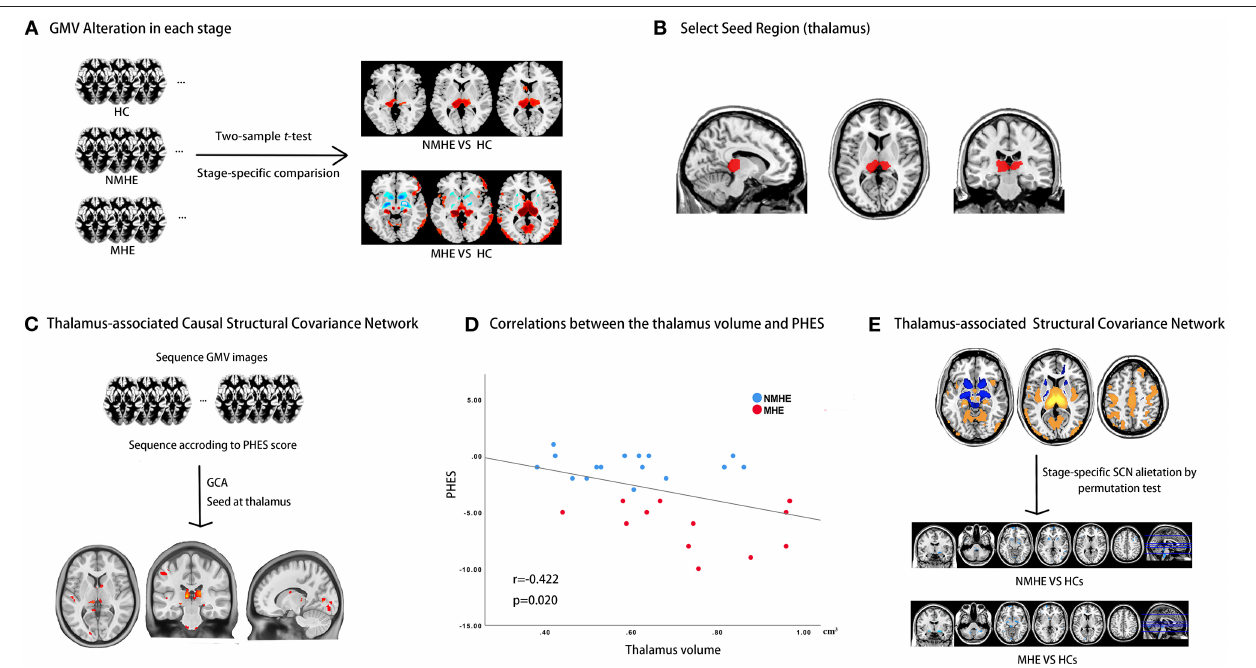
FIGURE 1 | Study design schematic. (A) HBV-RC patients were categorized into NMHE and MHE according to PHES; overall and stage-specific gray matter (GM) alterations were calculated by comparing overall cirrhotic patients, NMHE patients, and MHE patients with HCs separately. (B) The bilateral thalamus was extracted as the seed region based on prior analysis for subsequent causal network of structural covariance (CaSCN) analysis and structural covariance network (SCN) analysis. (C) The thalamus-associated CaSCN was constructed, and sequenced alterations related to the thalamus were derived during the progression of MHE. (D) The correlation between the thalamus volume and PHES in HBV-RC patients was evaluated by Spearman’s correlation analysis. (E) The thalamus-associated SCN was constructed, and stage-specific SCN alterations were calculated by a permutation test. GMV, gray matter volume; HC, healthy control; NMHE, patients without MHE;